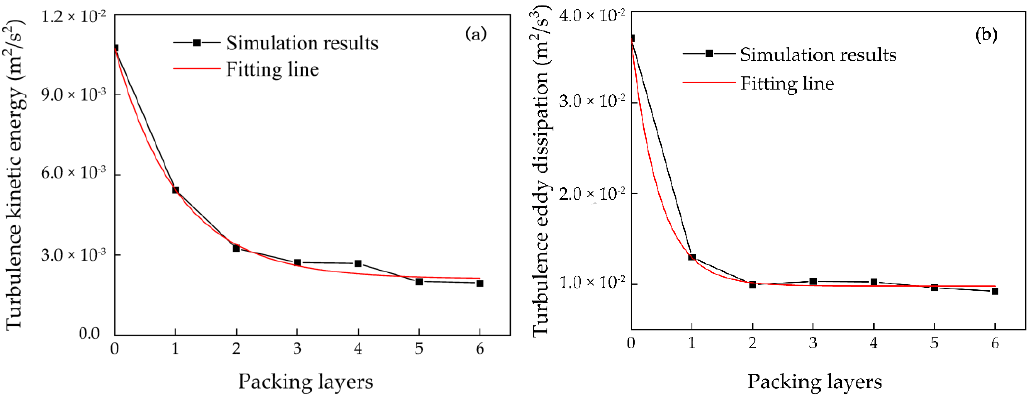
Figure 8. Influence of packing layers on volumetric average of ( a ) turbulence kinetic energy (TKE) and ( b ) turbulence eddy dissipation (TED).